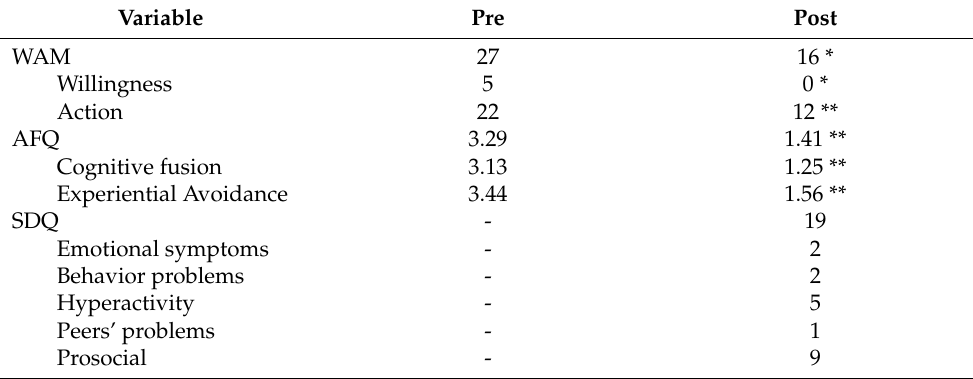
Table 3. Pre and post scores on David’s